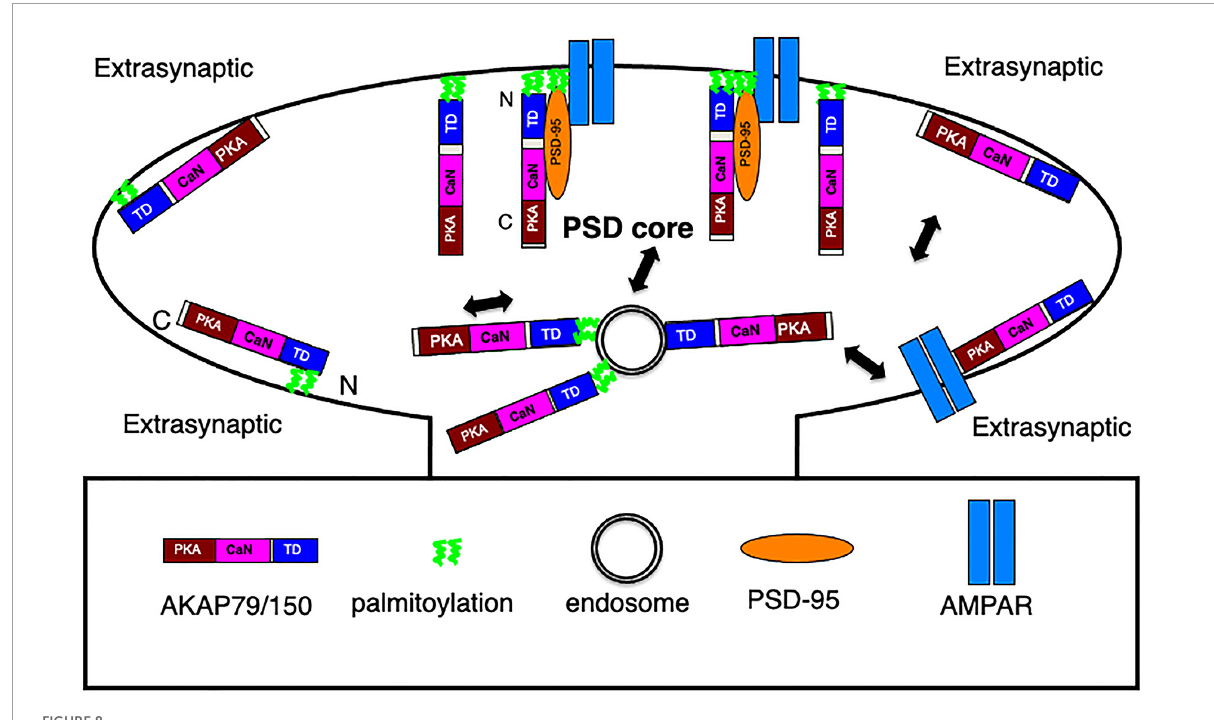
FIGURE8 Schematics of AKAP79/150 nano-scale organization, molecular configuration, and trafficking at an excitatory spine synapse. In the PSD, N-terminally palmitoylated AKAP associates with postsynaptic membrane in a vertical and extended configuration, some AKAP molecules are in complex with PSD-95 MAGUK, which also appears as vertical filament and anchors glutamate receptors at the PSD. At the extrasynaptic membrane, AKAP associates with the membrane primarily through N-terminal polybasic regions and secondarily through palmitoylation and is extended but oriented parallel to the membrane. Some may associate with extrasynaptic AMPARs. Both palmitoylated and non-palmitoylated AKAP150 molecules associate with recycling endosomes in spine, but with stronger/more stable association in the palmitoylated